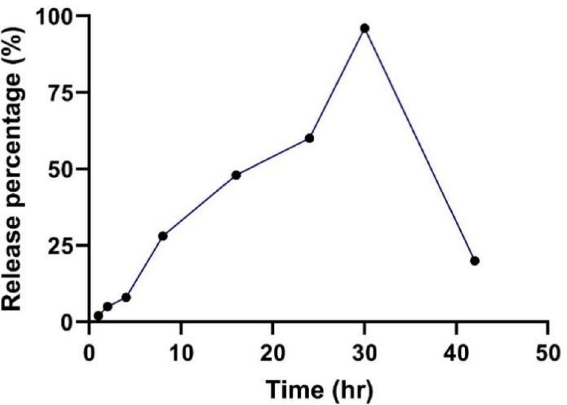
Figure 4. Releasing profile of BV from BV-loaded CS-NPs at different time intervals. BV: Bee venom, BV-loaded CS-NPs: Bee venom-loaded Chitosan nanoparticles.